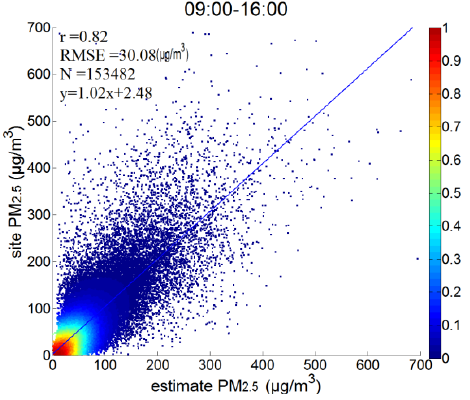
Figure 7. Scatterplots of satellite-retrieved and ground-measured PM 2.5 from January to June 2017 in Hebei.